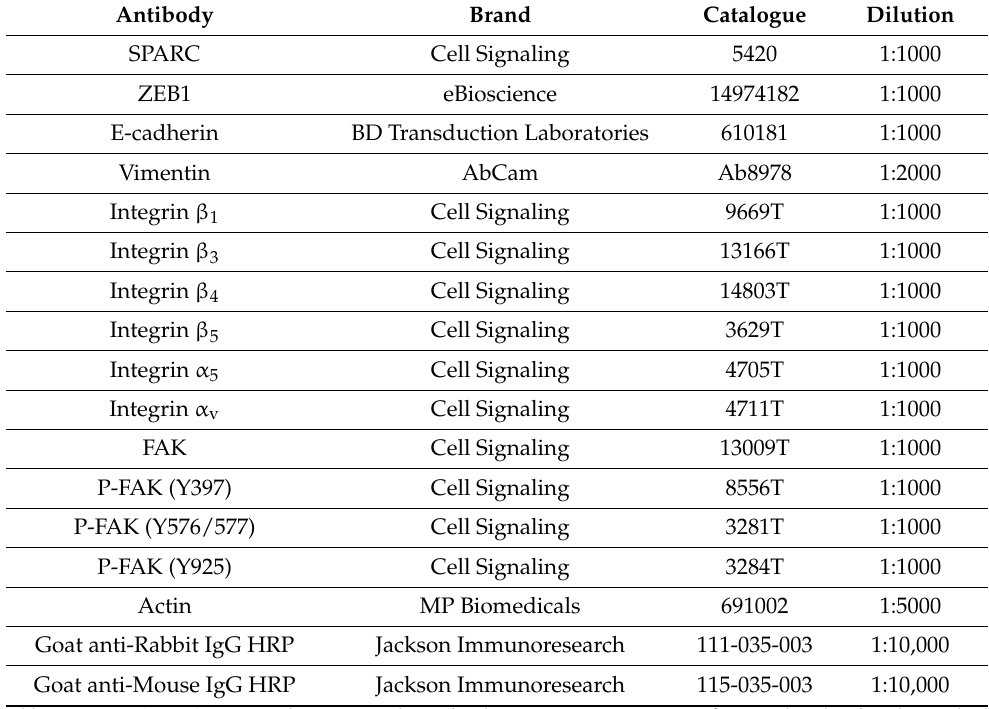
Table 1. Antibodies used for Western